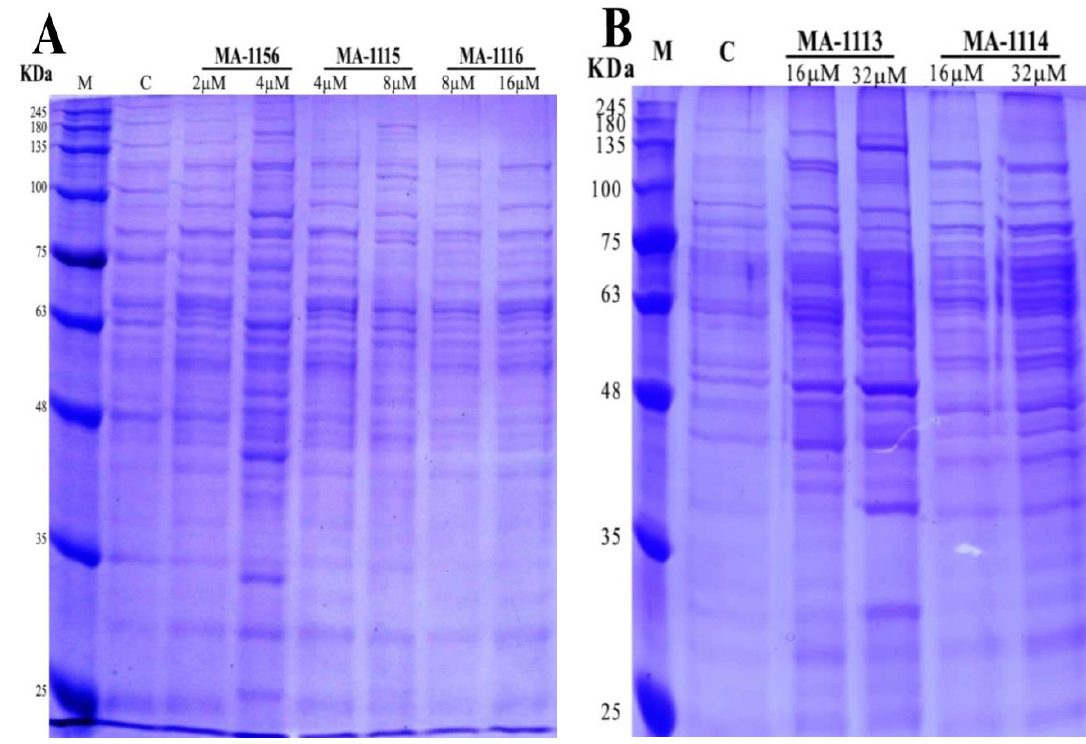
Figure 4. Protein pattern of S. aureus cultivated on Luria–Bertani (LB) broth media, ( A ) treated with MA-1156 (2 and 4 µM), MA-1115 (4 and 8 µM) and MA-1116 (16 and 32 µM) M = marker, C = control or untreated bacteria; ( B ) treated with MA-1113 (16 and 32 µM) and MA-1114 (16 and 32 µM).